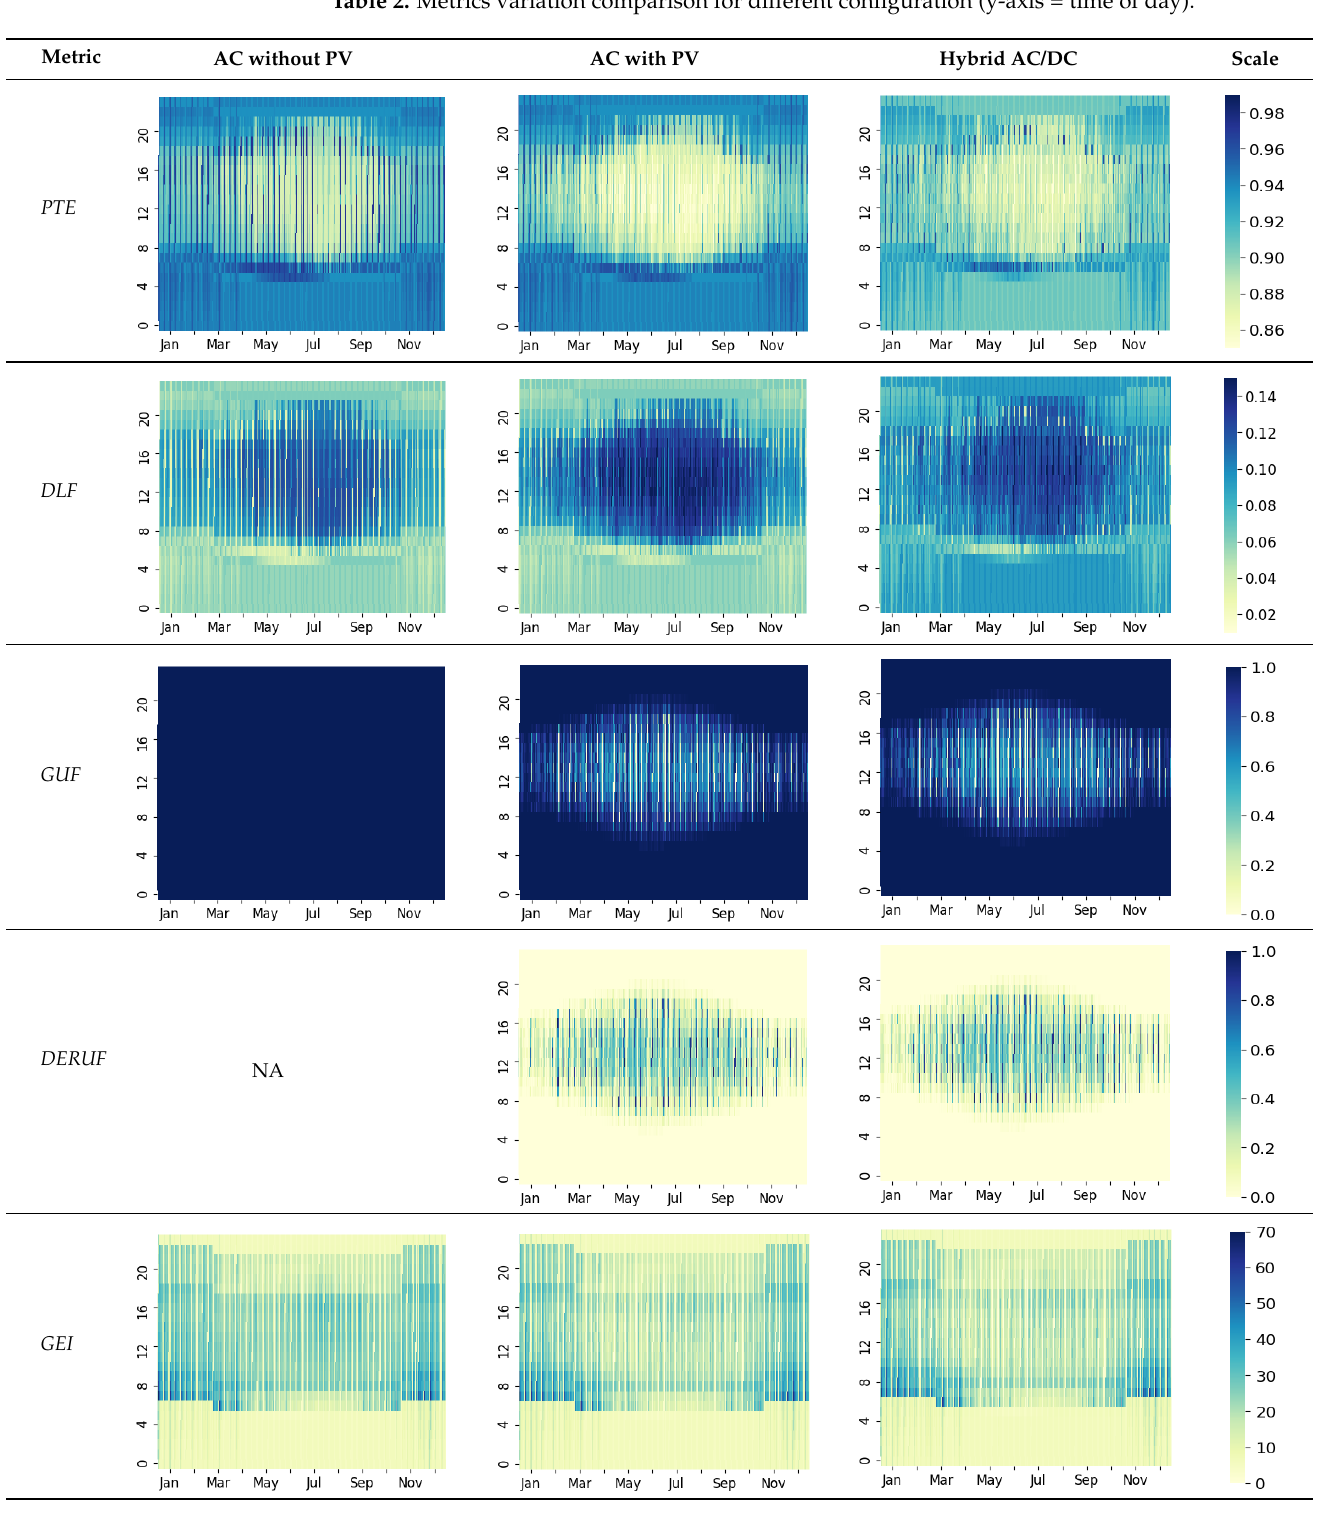
Table 2. Metrics variation comparison for different configuration (y-axis = time of